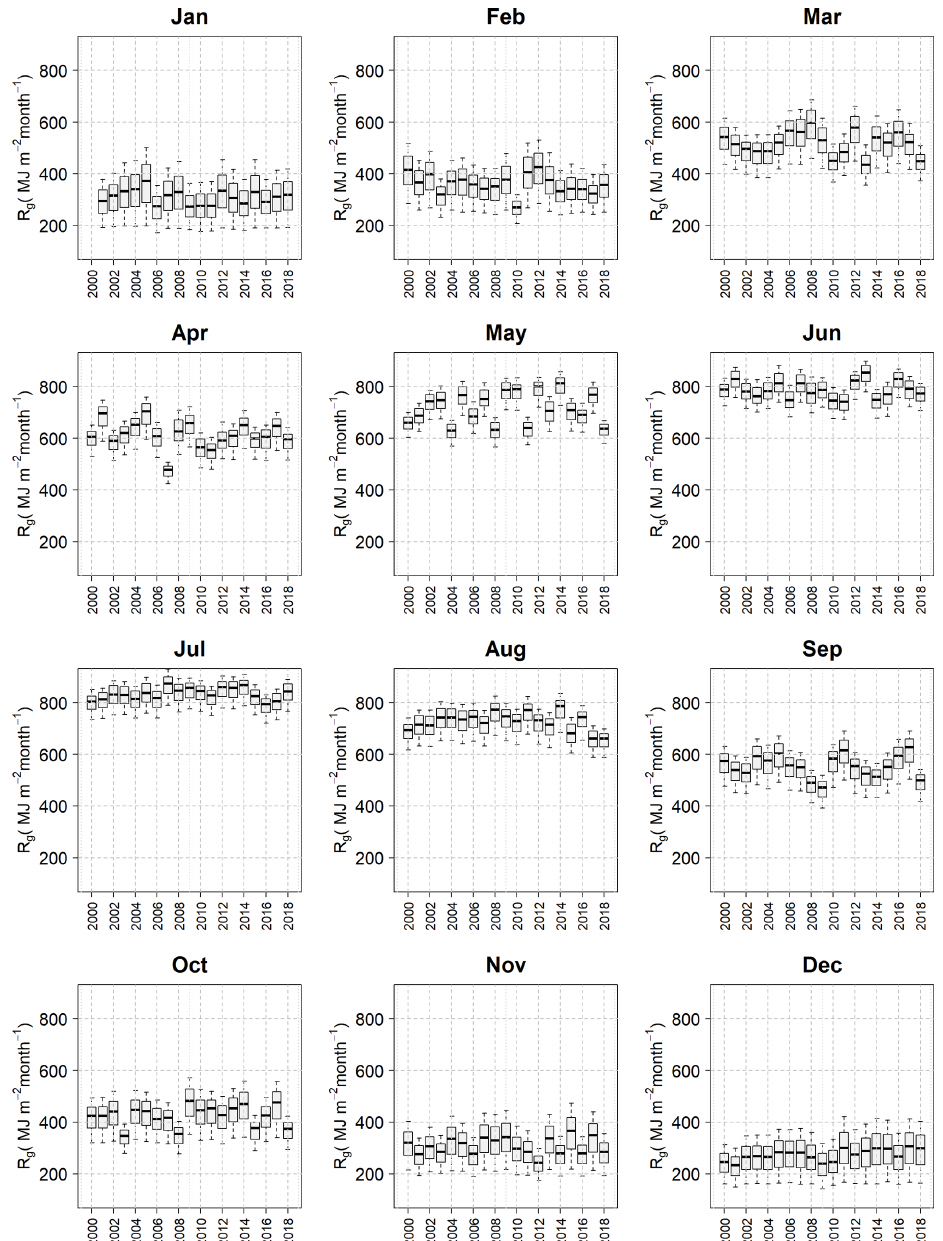
Figure 9. Statistical distribution of the monthly R g (MJm − 2 per month) values throughout the study area. Whisker boxes represent the 10th, 25th, 50th, 75th, and 90th percentiles of each monthly map per